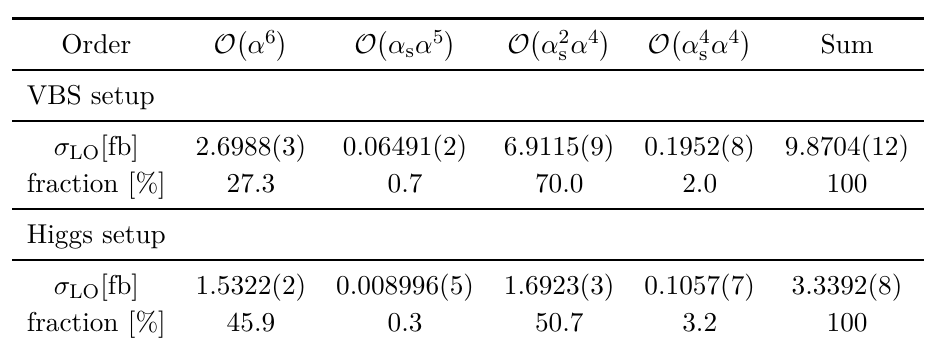
(cid:0) (cid:1) (cid:0) (cid:1) (cid:0) (cid:1) α 6 , α s α 5 , α 2 α 4 , and s O O O